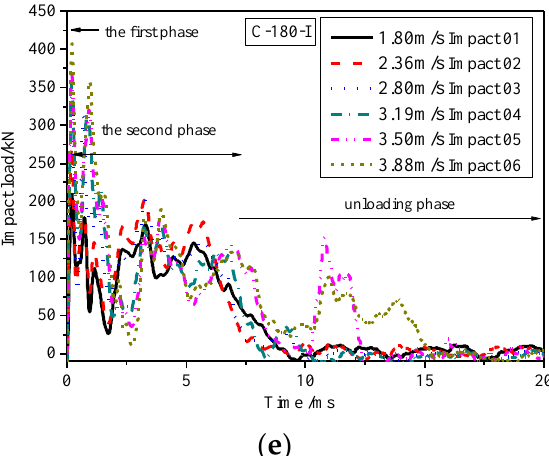
Figure 5. Impact load-time histories for all the specimens. ( a ) E-120-I; ( b ) E-120-U; ( c ) E-180-I; ( d ) E-180-U; ( e ) C-180-I.